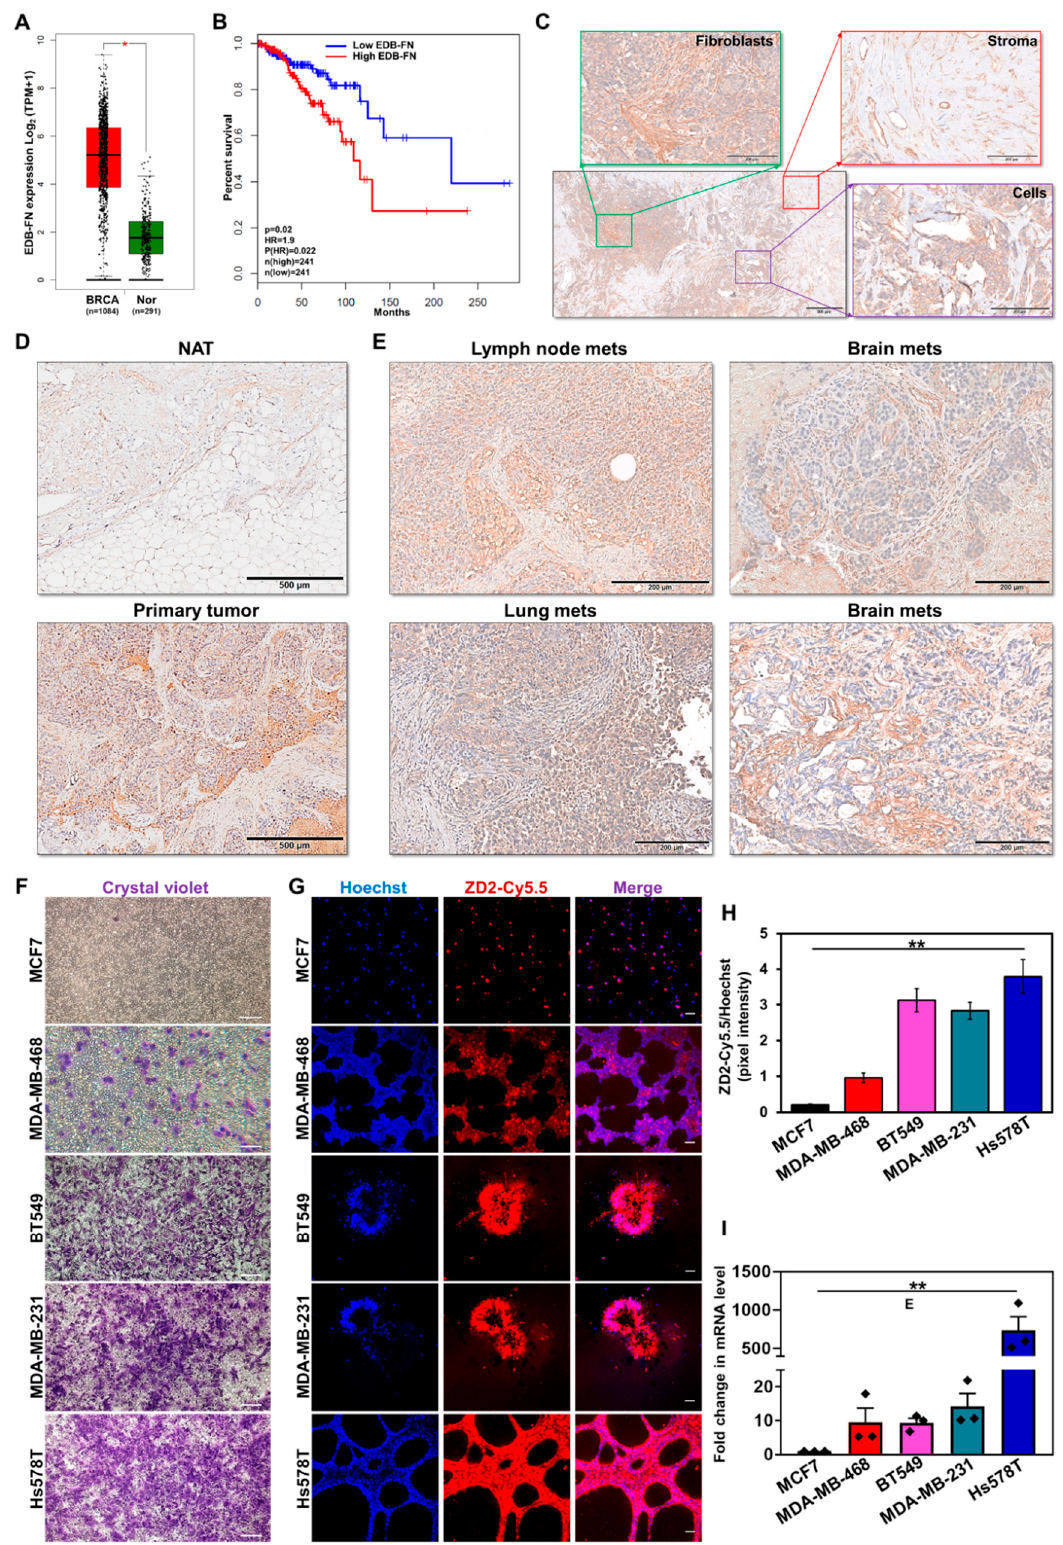
Figure 1. Extradomain-B Fibronectin (EDB-FN) overexpression in invasive breast cancer. ( A ) Differential gene expression analysis performed on patient data from the TCGA and GTEx databases shows significant overexpression of EDB-FN isoform (ENST00000432072.6) in breast tumor samples (BRCA, n = 1084) compared to normal breast tissue samples (Nor, n = 291). Box plot denotes log 2 (TPM+1) transcripts per million values and median with interquartile range, * p = 6.57 × 10 − 69 using ANOVA. ( B ) Kaplan–Meier curves show overall survival analyses of breast cancer patients with EDB- FN expression (* p < 0.05; * p for Hazard ratio = 0.022 using Log-rank test, i.e., Mantel-Cox test). ( C )